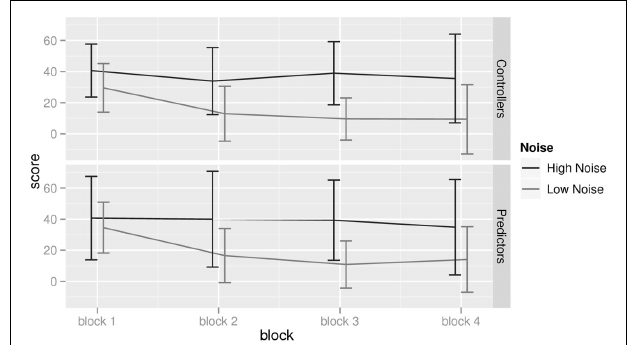
FIGURE 2 | Error scores ( ± SE) in the learning phase of Experiment 1. For Controllers, these are control error scores, and for Predictors, these are predictive error scores.